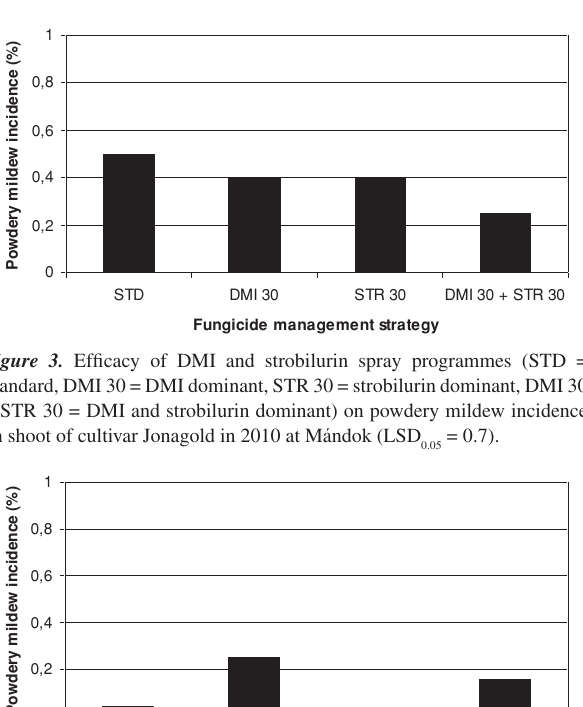
Figure 1. Effi cacy of DMI and strobilurin spray programmes (STD = Figure 4. Effi cacy of DMI and strobilurin spray programmes (STD = Standard, DMI 30 = DMI dominant, STR 30 = strobilurin dominant, DMI Standard, DMI 30 = DMI dominant, STR 30 = strobilurin dominant, DMI 30 30 + STR 30 = DMI and strobilurin dominant) on apple scab incidence on + STR 30 = DMI and strobilurin dominant) on powdery mildew incidence leaves (black coloumn) and fruits (white coloumn) of cultivar Jonagold in on shoot of cultivar Jonagold in 2010 at Ófehértó (LSD 2010 at Mándok (LSD = 6.2 – leaf; LSD = 4.4 – fruit). 0.05 0.05